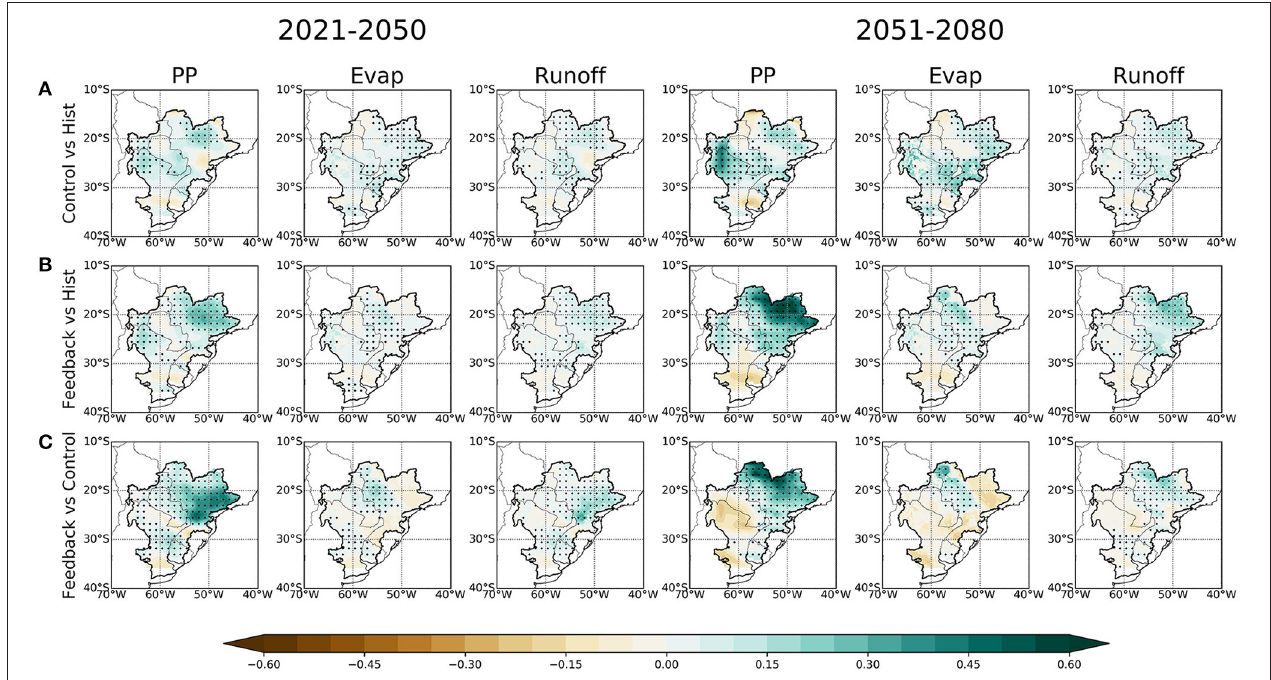
FIGURE 3 | Annual projected changes in total precipitation, evaporation, and runoff (mm/day) derived from the three-member ensemble mean values for two future 30-year periods (2021–2050 and 2051–2080) and the mean values over the historical period (1980–2010): (A) Projected changes under the RCP8.5 emission scenario (control simulations) relative to historical, (B) projected changes for the geoengineering simulations combined with the RCP8.5 pathway (feedback simulations) relative to historical, and (C) the difference between (A,B) . Stippling indicates robust changes according to the definition of robustness adopted in this study [see section projections in the text for further details].